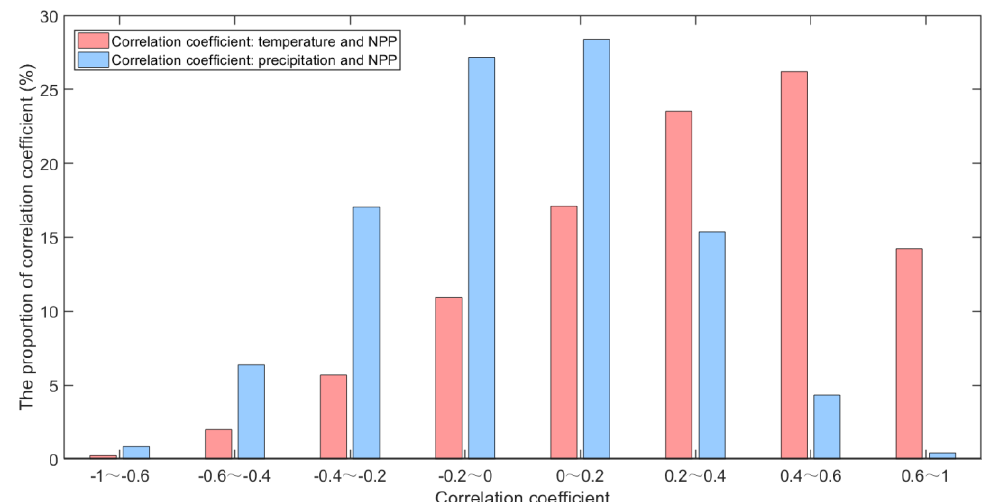
Figure 9. The proportion of different correlation coefficient ranges.